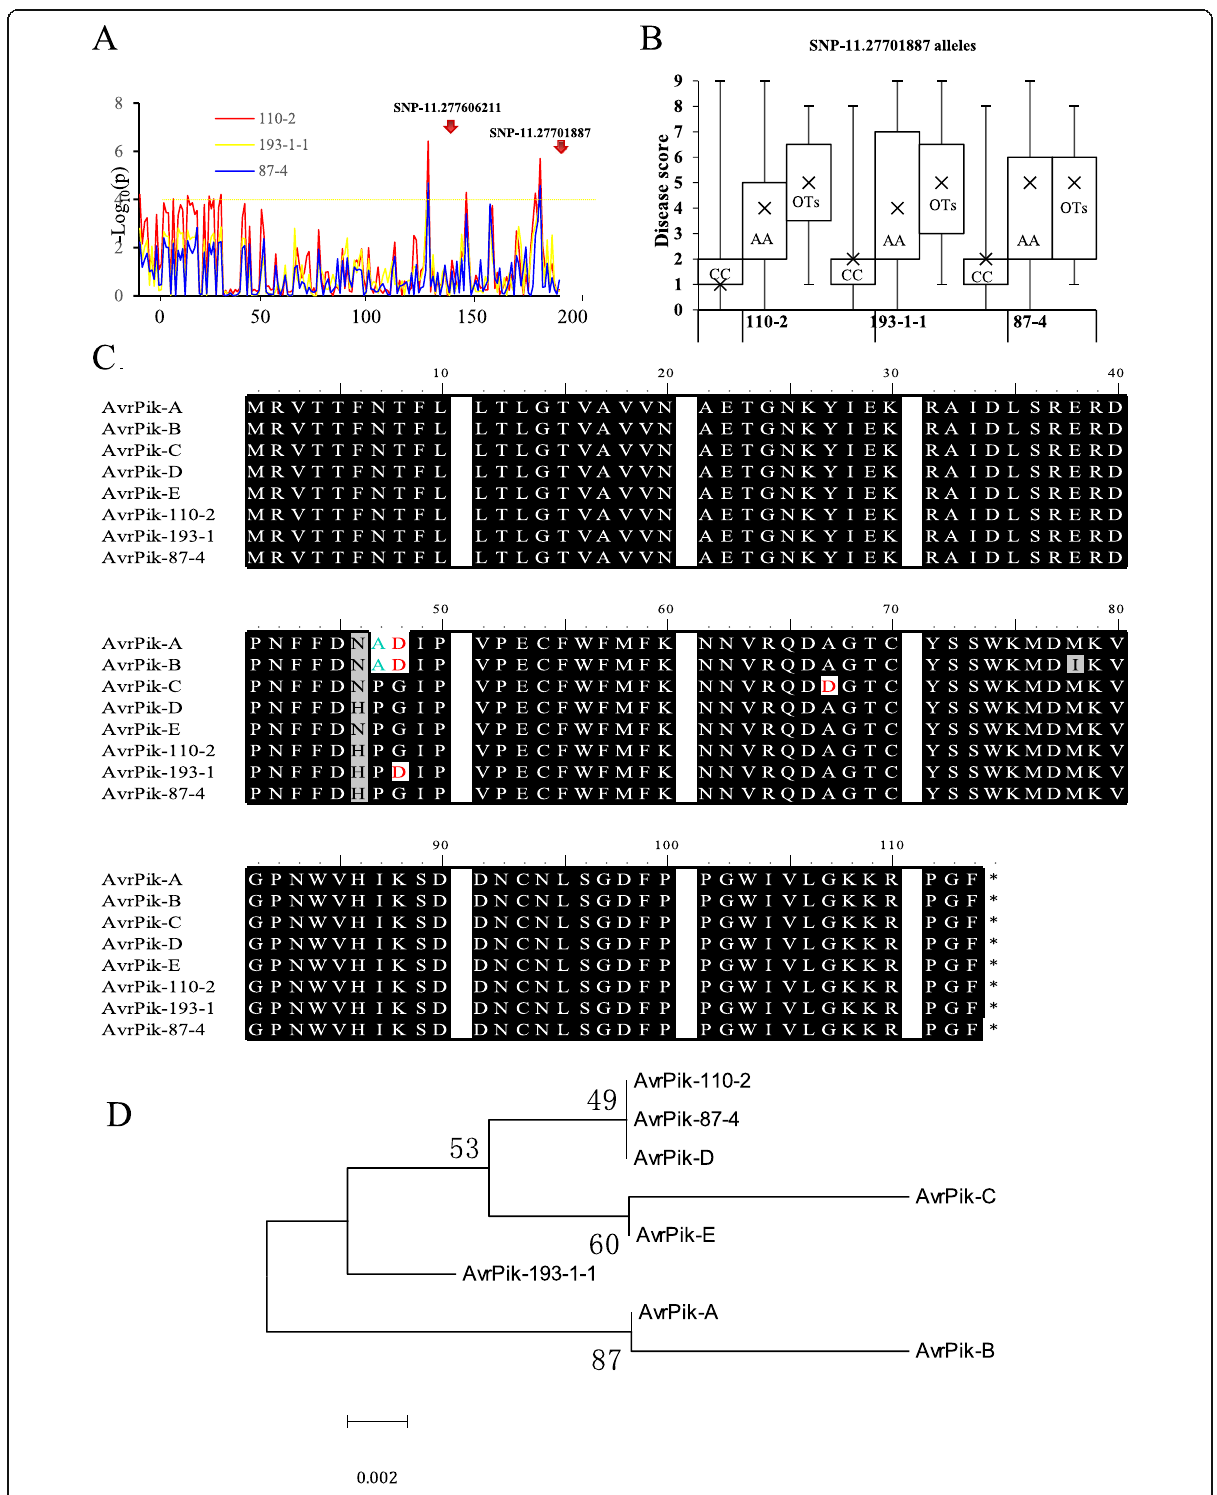
Fig. 3 Relationship between QTL50 and Pik and the AvrPik sequences in the three isolates a SNP-11.27701887 is the most significant SNP that is associated with resistance to all three M. oryze isolates in QTL50. b SNP-11.27701887 alleles distribution in the 234 RDP1 cultivars. CC, AA and OTs represent the genotype AA, CC and other type of SNP-11.27701887, respectively. c Sequence alignment of the AvrPik amino acid sequences using ClustalW. Shading fonts indicate common amino acid residues in the alleles. d Phylogeny tree of the AvrPik genes from three M. oryze